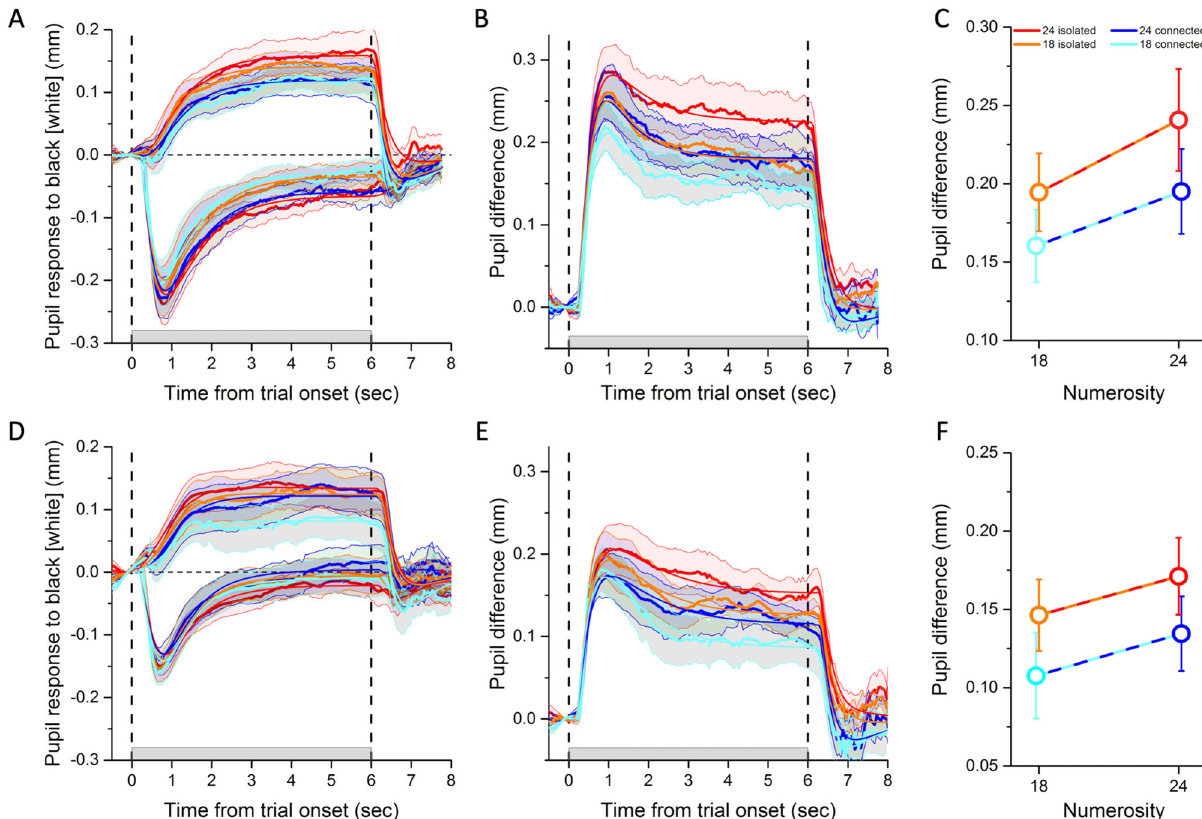
Fig. 3 Pupil responses to different numerosities and connectedness levels. A Pupil dilation or constriction in response to black or white stimuli for the displaced-lines condition (experiment 1). Color-coded lines refer to the different numerosity and connectedness levels de fi ned in the legend to C . The gray shaded area on the abscissa between the two vertical dashed lines show time of stimulus presentation. Thick lines plot the time courses of the pupil size averaged across participants ( N = 16 participants) and the shaded area around them the SEM. Thin color-matched lines show the average fi t obtained by convolving stimulus predictors with the pupil response function (de fi ned by parameters listed in Supplementary Table 1). B Time course of the pupil difference (dark minus light responses) estimating the net pupillary response to luminance. C Average pupil difference in the interval 1 – 6 s after stimulus onset (the stimulus duration minus the fi rst second, which we excluded to discard the fast and transient pupillary onset response). Dots represent averages across participants ( N = 16 participants) and error bars are SEM. D – F Same as A – C , for the removed-lines condition (experiment 2). Open circles represent averages across participants ( N = 13 participants) and error bars are SEM. Repeated-measures ANOVAs tested for pupil differences between numerosity and connectedness levels. Signi fi cance of main effects and interactions are reported in text. The results from the fi rst experiment ( A – C ) were replicated in the second one ( D – F ). Source data are provided as a Source Data fi